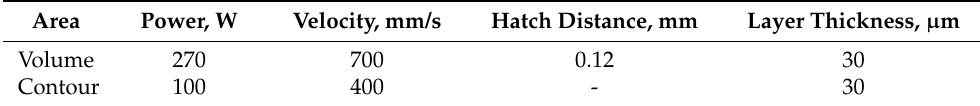
Figure 1. Characteristic secondary-electron (SE) micrograph of AISI H13 powder used in the present study. Some satellites and oval particles are highlighted with white arrows. Table 1. Process parameters used for manufacturing AISI H13 samples [26].